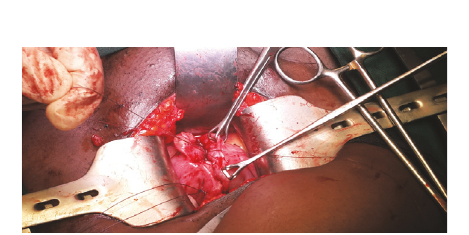
Figure 3: Ongoing metroplasty.